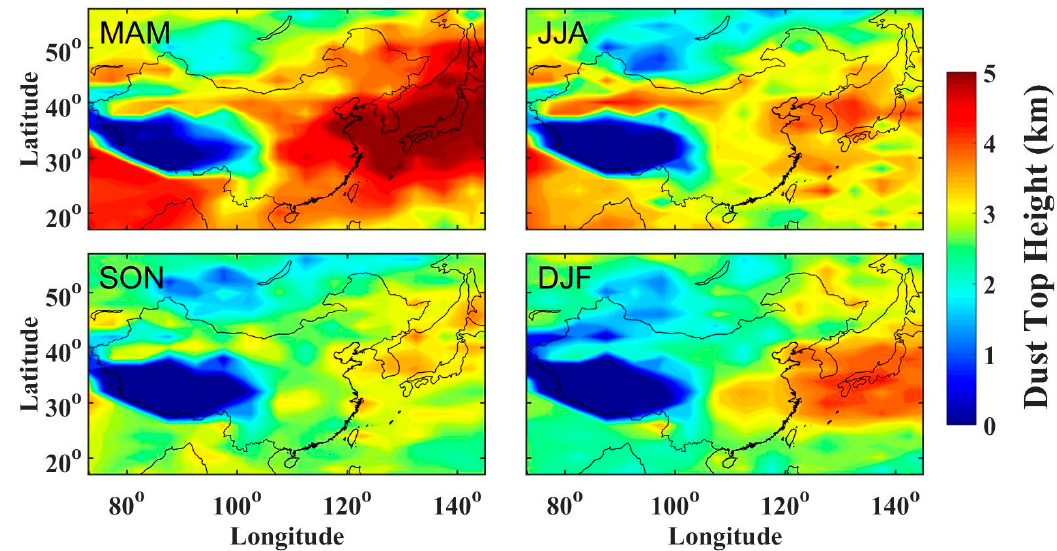
Figure 4. The seasonal distribution of dust Top Height (km) over East Asia based on CALIPSO data.